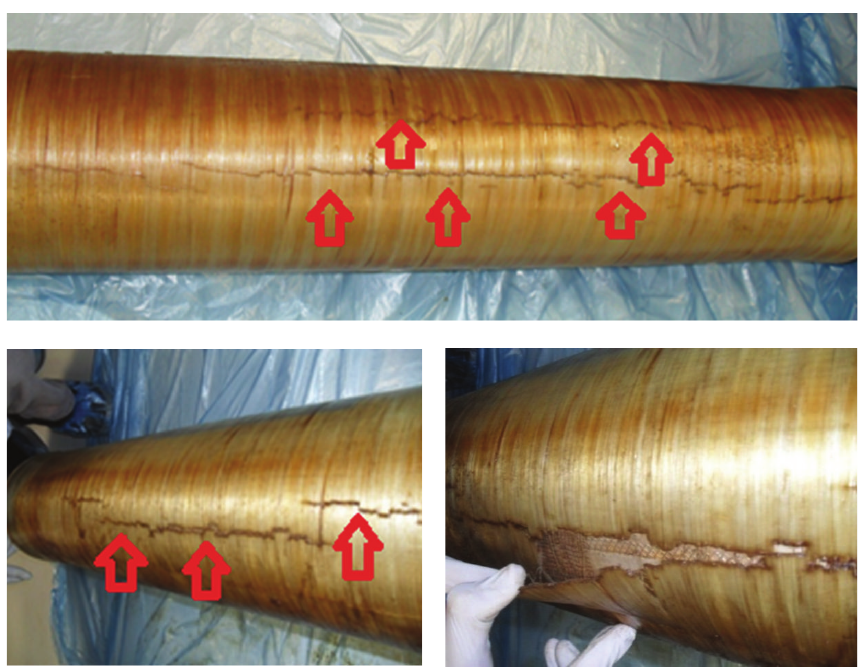
Figure 2: Cracked module shells due to high pressure drop (arrows indicate cracks).